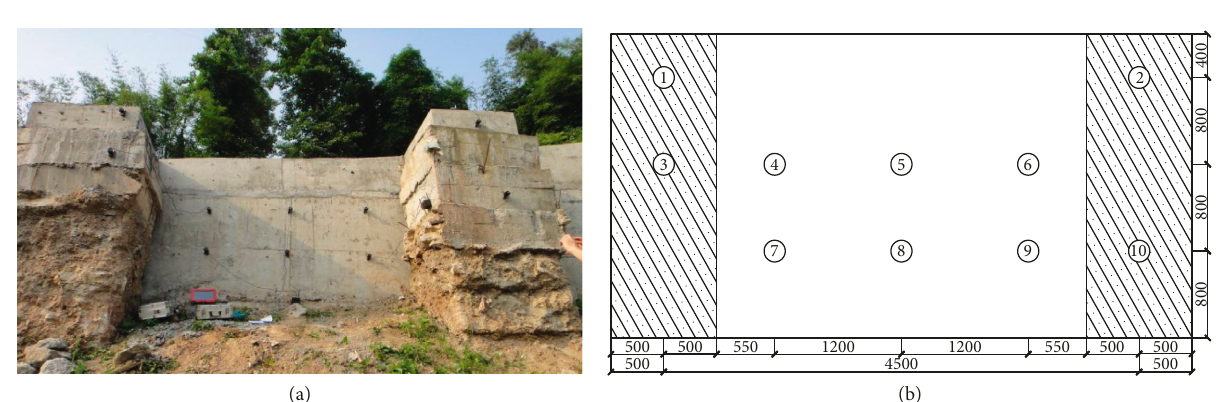
Figure 20: Pile plate retaining wall in field tests. (a) Vibration tests. (b) Assignment of sensors (unit: mm).